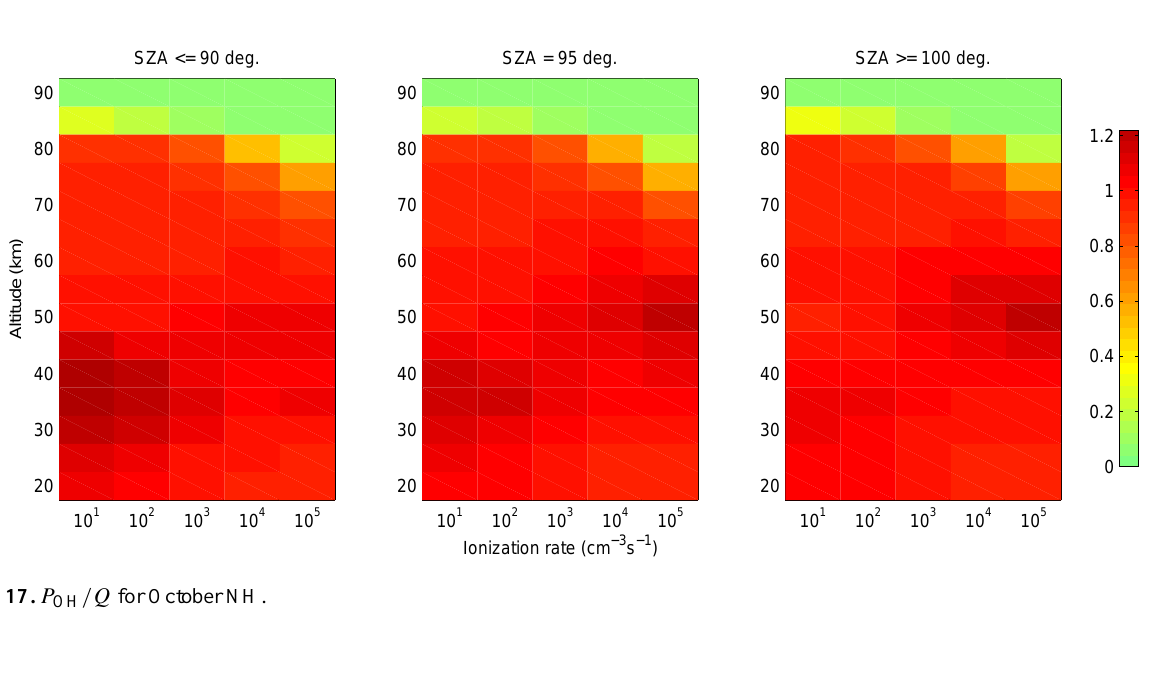
Fig. A17. P OH /Q for October